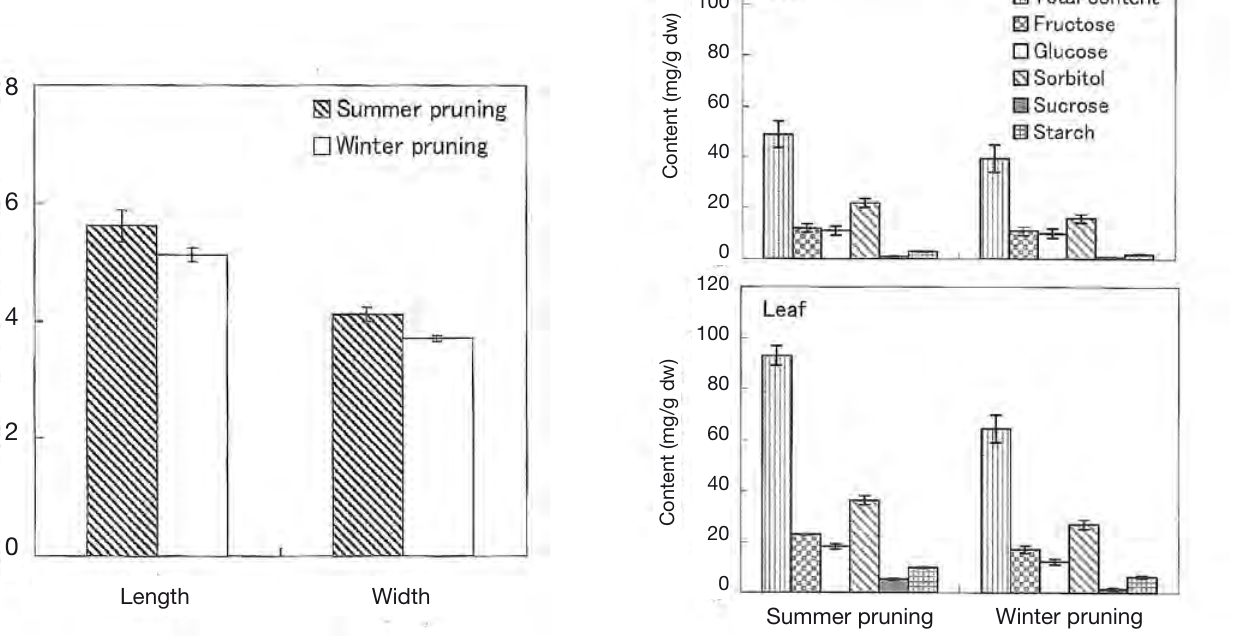
Fig. 6 - Effect of summer and winter pruning on sugar and starch con - tent in stems and leaves in peach trees on 4 April. Data are presented as mean ± standard error ( se